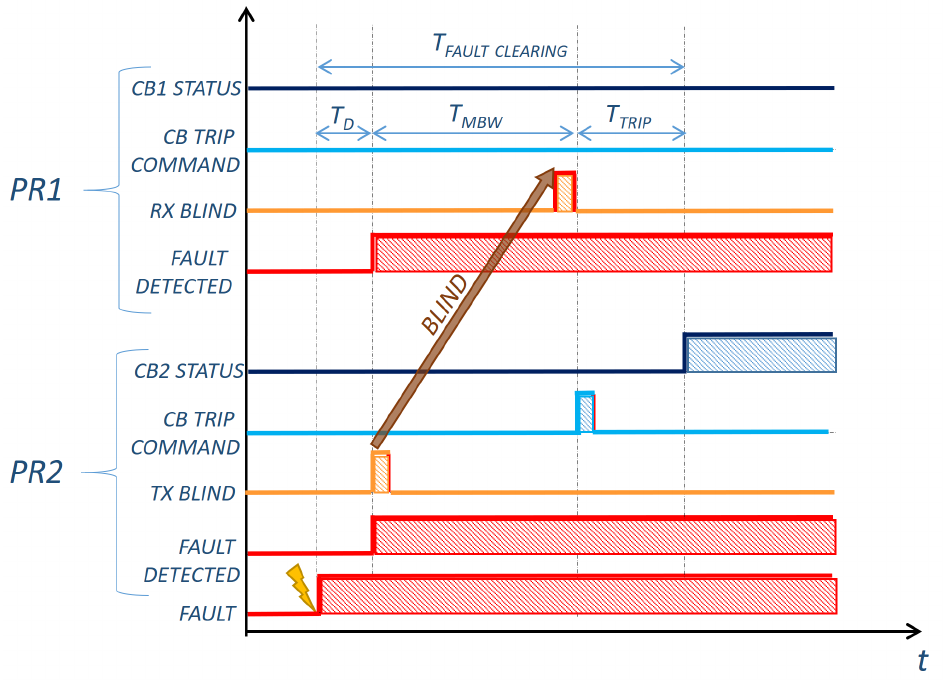
Figure 2. Timing of the operations of PR1 and PR2 if a fault downstream of PR2